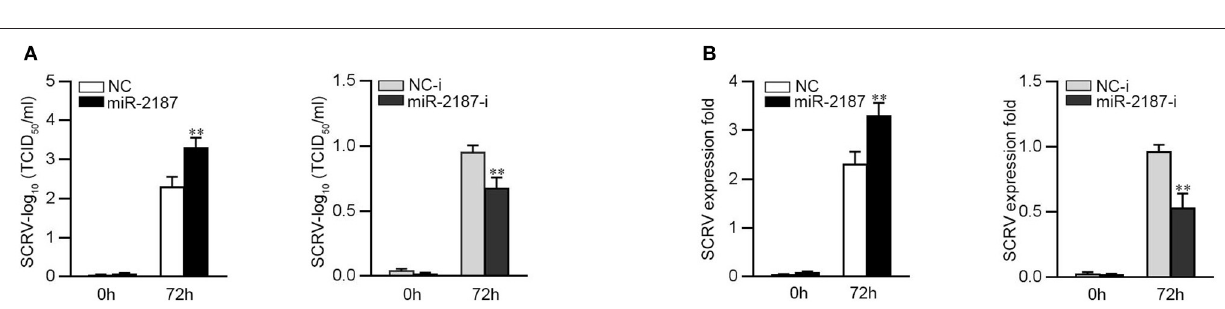
clearance effect on pathogen invasion (41–43). However, the excessive activation of TLR or RIG-I signals can disrupt the immune balance and cause